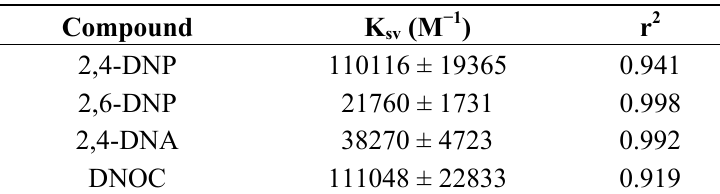
Table 1. Fluorescence quenching characteristics obtained using linear regression Stern-Volmer Equation (1).